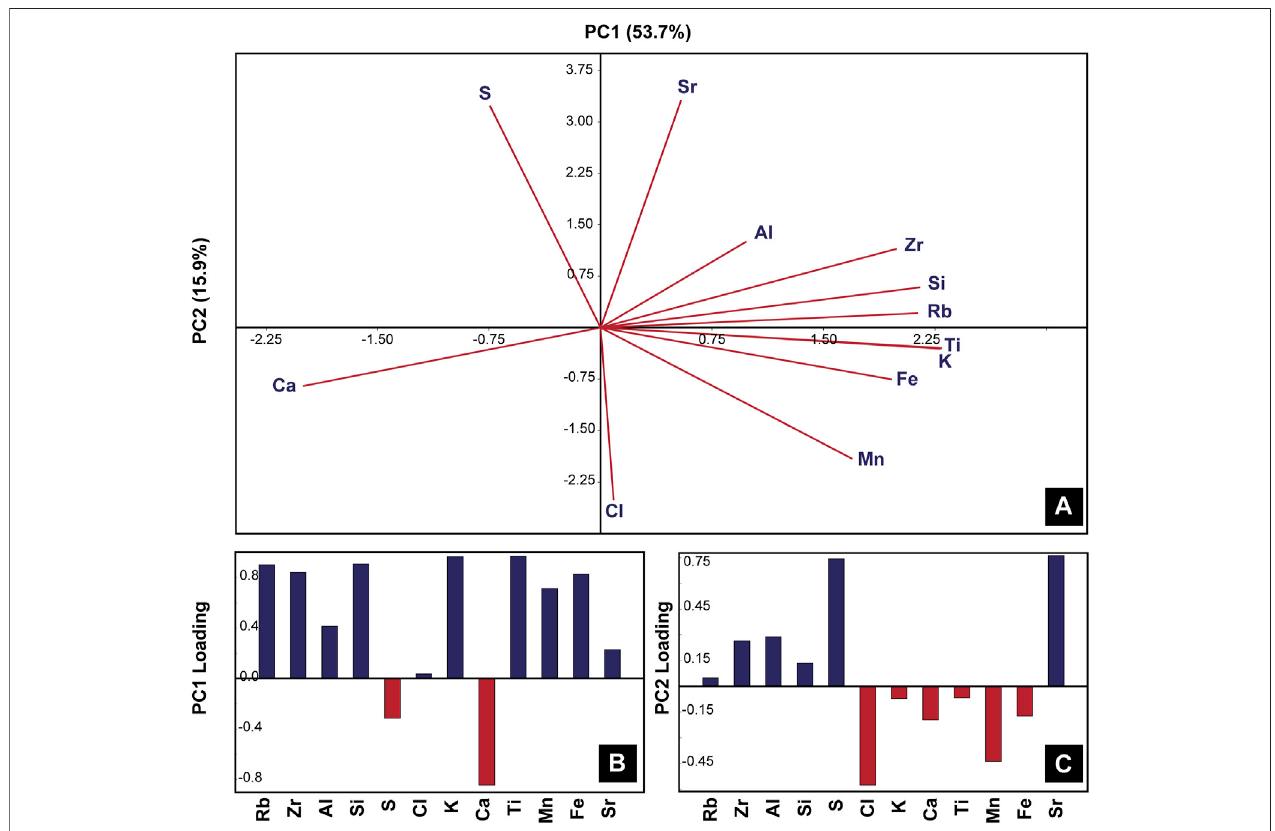
FIGURE5| StatisticalanalysesoftheXRFdata. (A) PrincipalComponentAnalysis(PCA)andbiplotbetweenPC1andPC2showingthegeochemicalparametersof composite core GBW. (B) Loadings of principal components (PC1) derived from elemental data. (C) Loadings of principal components (PC2) derived from elemental